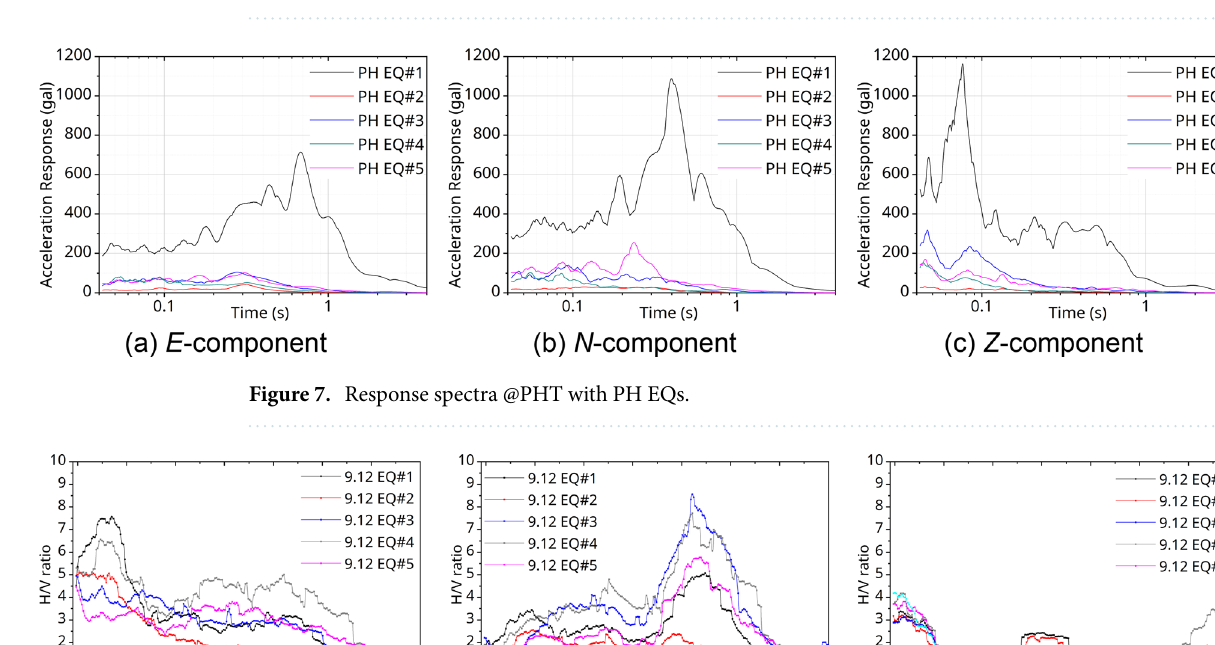
Figure 6. Response spectra @PHT with 9.12 EQs.